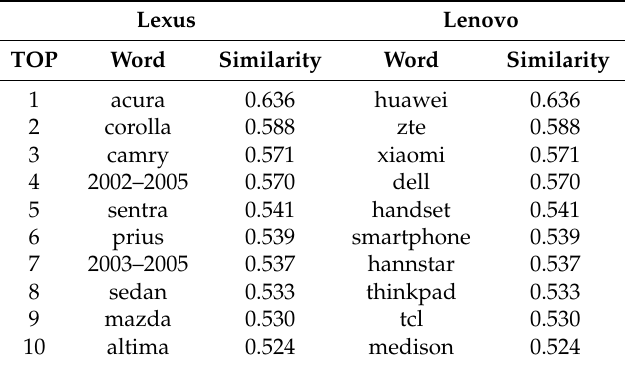
Table 2. Example of similarity relationship for English